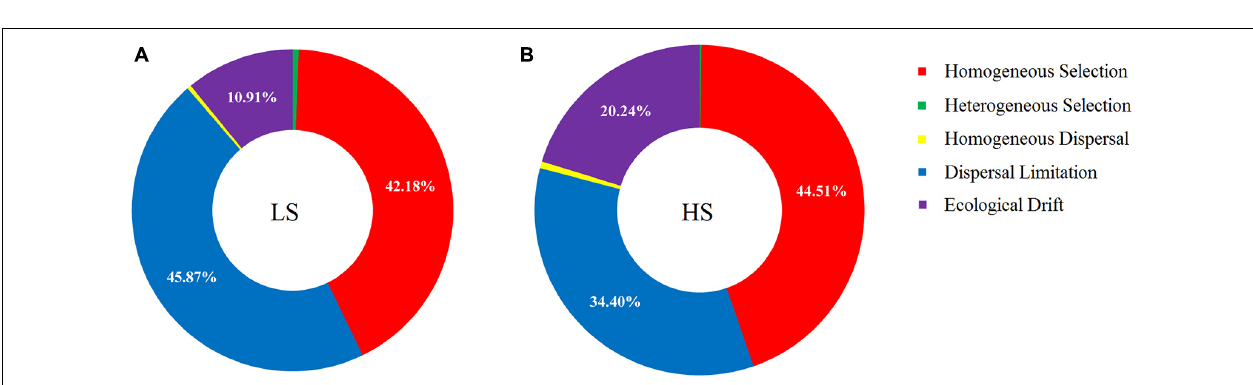
FIGURE 5 | Bacterial co-association network of shrimp intestine in the LS and HS groups. Shrimp intestine bacterial interspecies interactions in the LS (A) and HS (B) groups. Each node represents a bacterial OTU. The colors of nodes indicate OTUs affiliated to different phyla. A blue edge indicates a positive interaction between two individual nodes, whereas a red edge indicates a negative interaction.